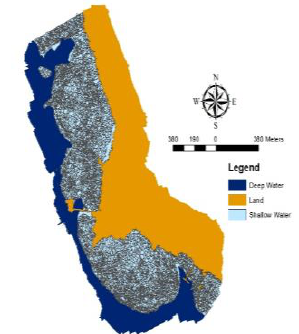
Fig. 4. Image segmentation results using multi resolution algorithm by using coverage (below)